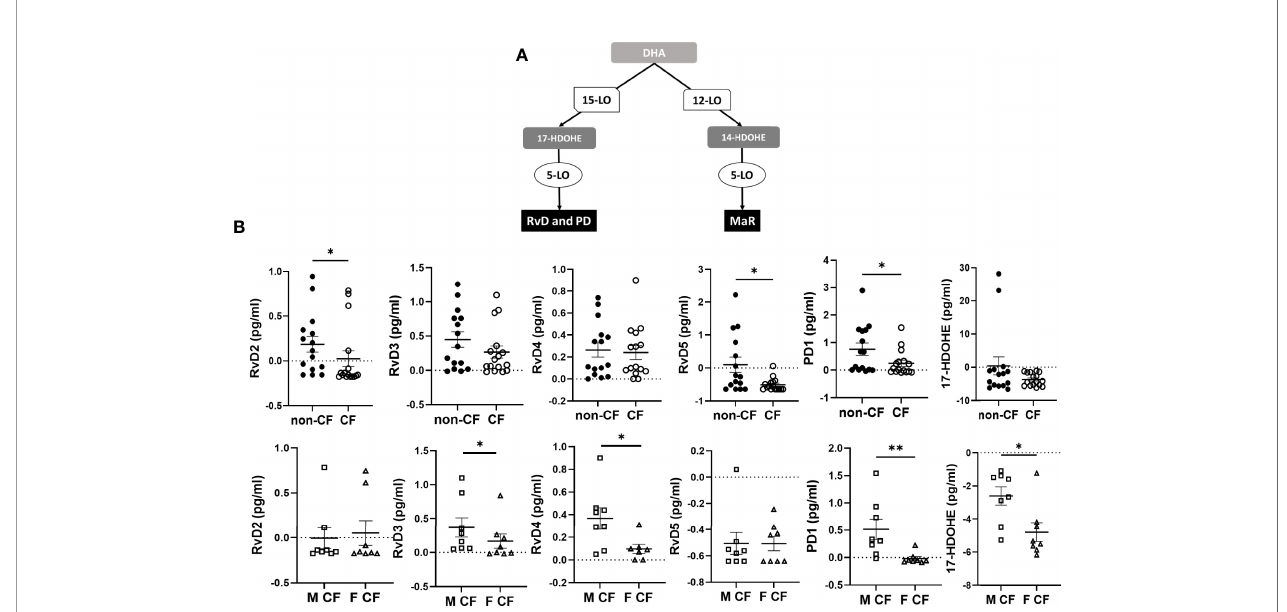
FIGURE 3 | Docosahexaenoic acid (DHA) metabolites biosynthesis. (A) Schematic illustration of the D-series of resolvins (RvD), protectins (PD) and maresins (MaR) biosynthesis ’ pathway showing the enzymes involved, 5-LO, 15-LO and 12-LO as well as their intermediates substrates 17-HDOHEand 14-HDOHE. (B) Comparison of the mean levels of each DHA metabolite (RvD2, rvD3, RvD4, RvD5, PD1 and 17-HDOHE) between samples derived from non-CF and CF subjects (top) and from male and female CF patients (bottom). (Mann-Whitney test. *p<0.05), **p<0.01).